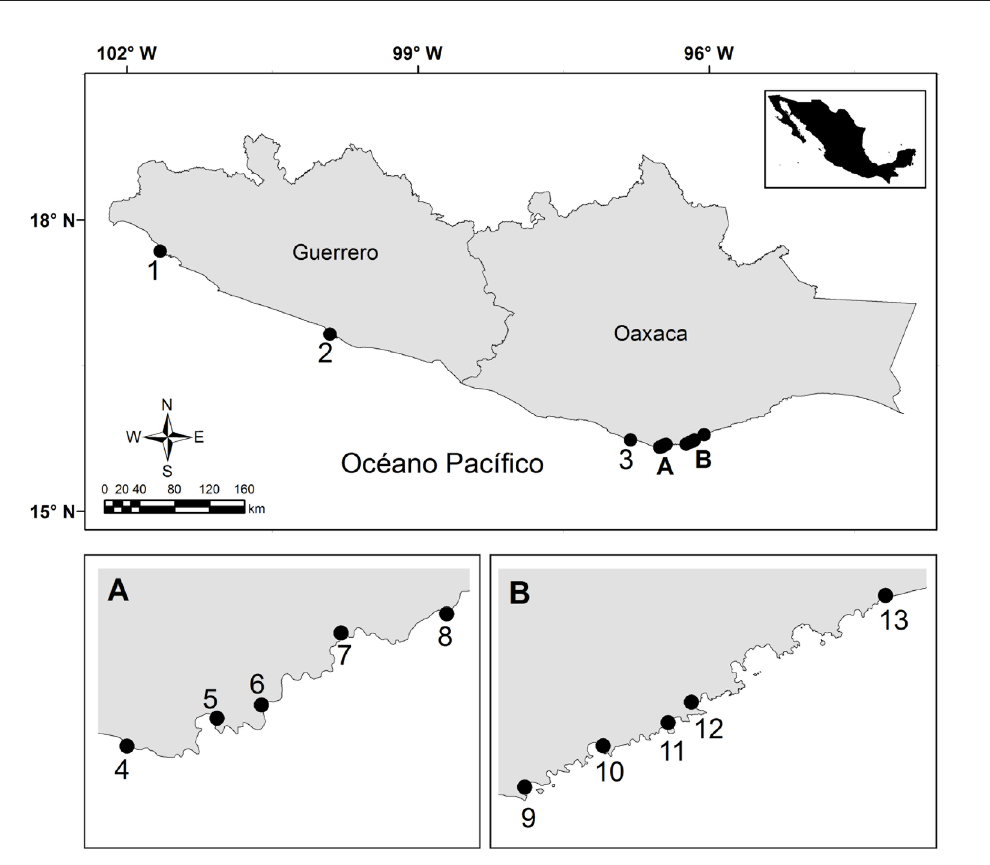
Fig. 1. Study area. Guerrero: 1 . Coral Beach. 2 . La Roqueta Island. A–B . Oaxaca: 3 . Agua Blanca Beach. 4 . Zipolite, Playa del Amor. 5 . Puerto Ángel Bay. 6 . Estacahuite Beach. 7 . La Boquilla Beach. 8 . La Tijera Beach. 9 . San Agustín Bay. 10 . Chachacual Bay, Jicaral Beach. 11 . Cacaluta Bay. 12 . El Maguey Bay. 13 . Copalita